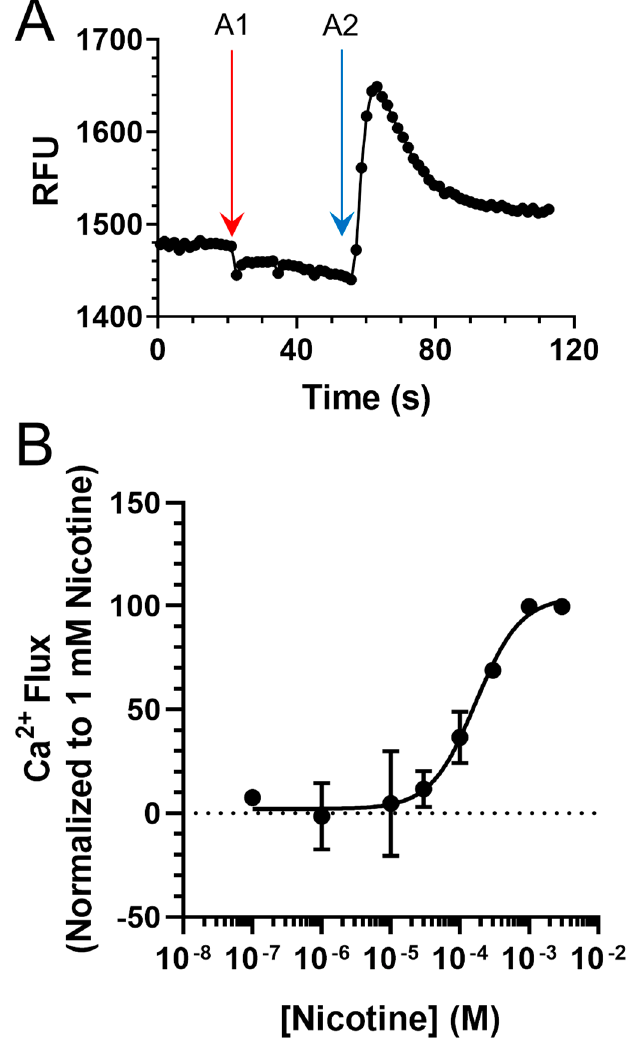
Figure 3. ( A ) Representative Ca 2+ Flux trace from a single 96-well plate seeded with cells transiently transfected with mouse α 4 β 2 nAChRs. A1 and A2 designate drug additions 1 (vehicle) and 2 (100 µM nicotine). ( B ) Concentration–response of nicotine on neuroblastoma-2a cells transiently transfected with α 4 β 2 nAChRs. Data are mean ± SEM and are normalized to 1 mM nicotine. For B, n = 6 individual experiments.